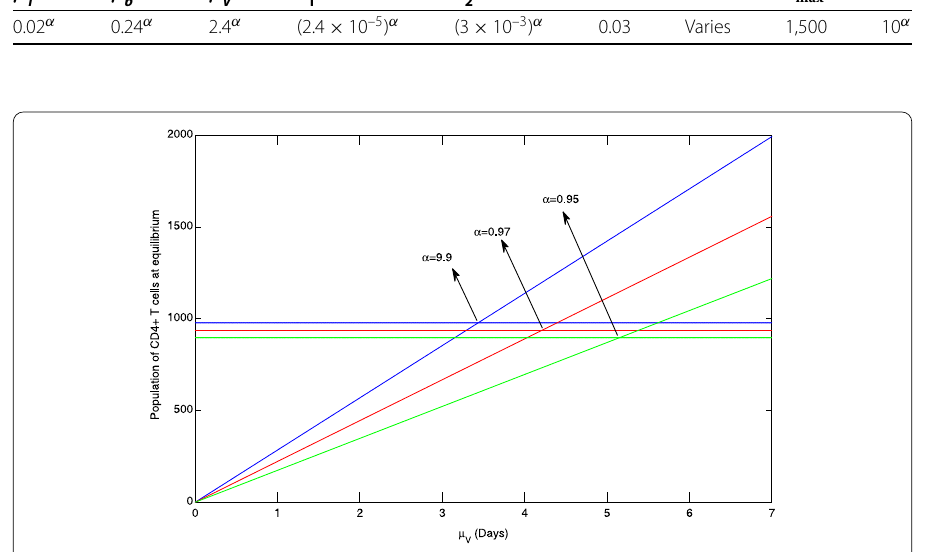
Figure 1 Bifurcation diagram (viral death rate), N =